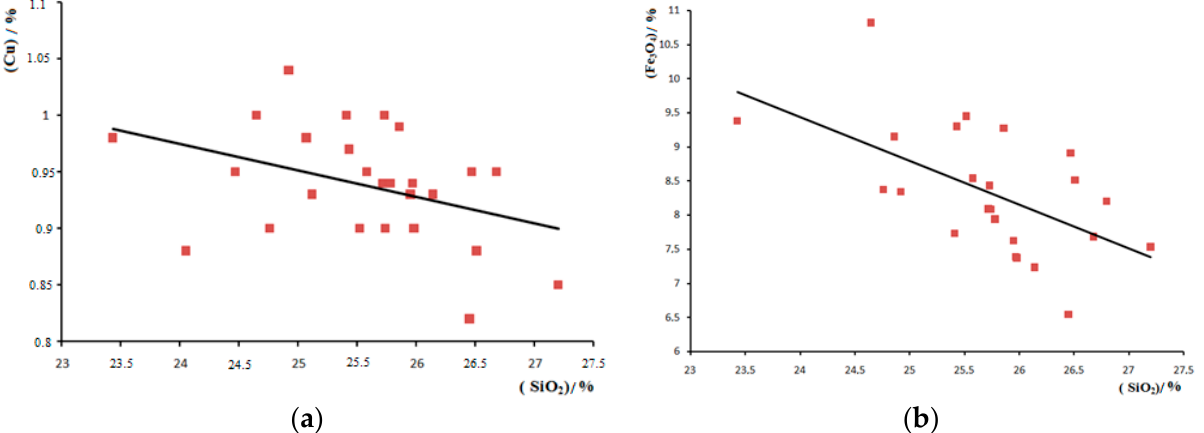
Figure 2. ( a ) Dependence of the copper content in slags on the content of silica in slags; ( b ) dependence of the content of magnetite in slags on the content of silica in slags.